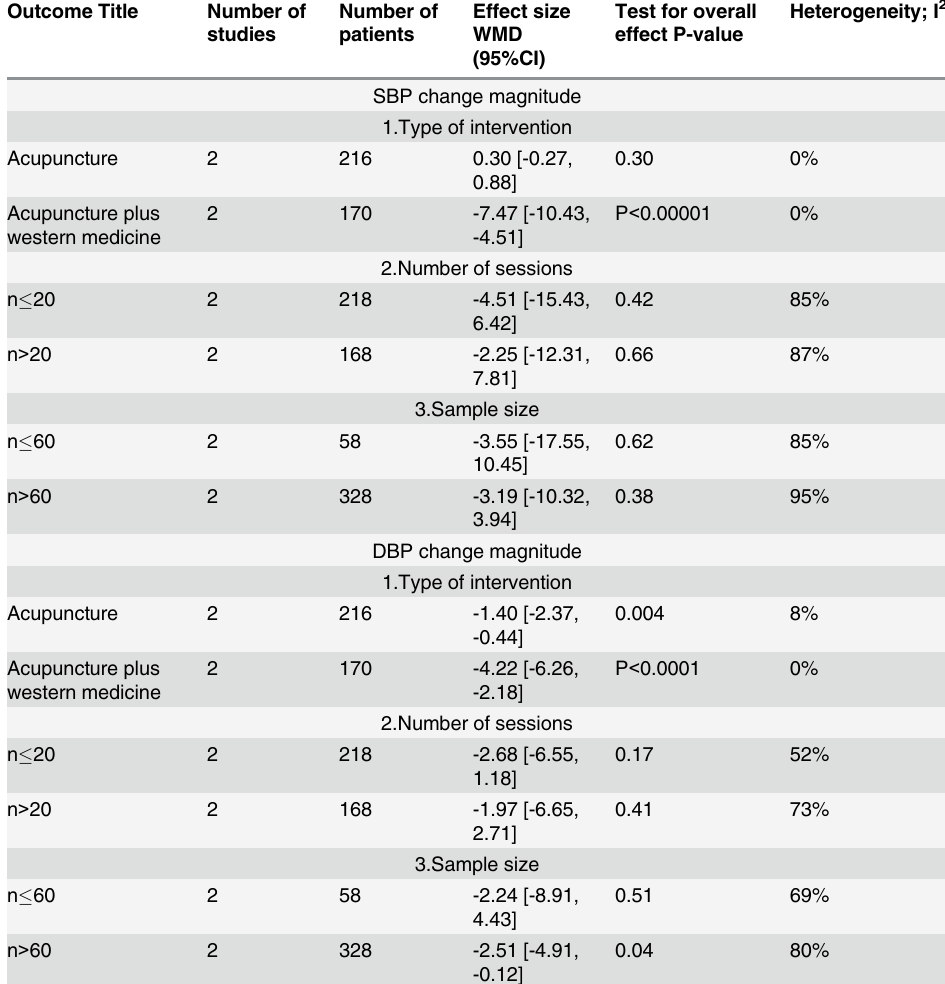
Table 3. Subgroup analysis and investigation of heterogeneity on SBP/DBP change